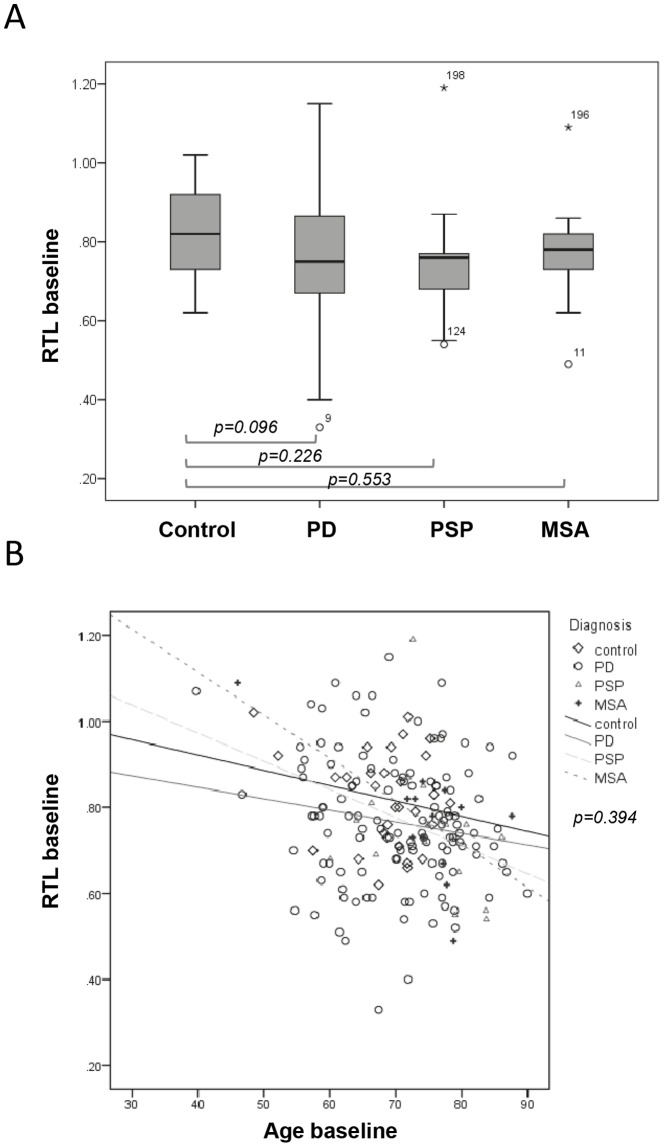
Telomere length characteristics at baseline.A) Mean relative telomere length (RTL) at baseline in control (n = 30), PD (n = 124), PSP (n = 17) and MSA (n = 13) samples. Age-adjusted p-values comparing control with patient subgroups. B) RTL as a function of age at baseline with regression lines. Correlation between telomere length and age in control and patient subgroups examined using the Pearson's correlation coefficient. No significant (p = 0.394) difference in the relationship between RTL and age was found in control and patient groups.